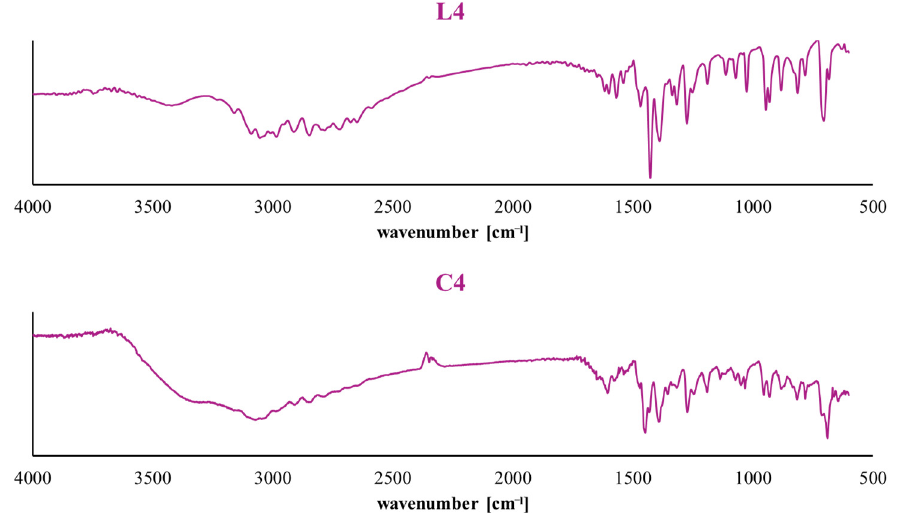
Figure 3. FTIR spectrum of free organic ligands L4 and complex C4 .